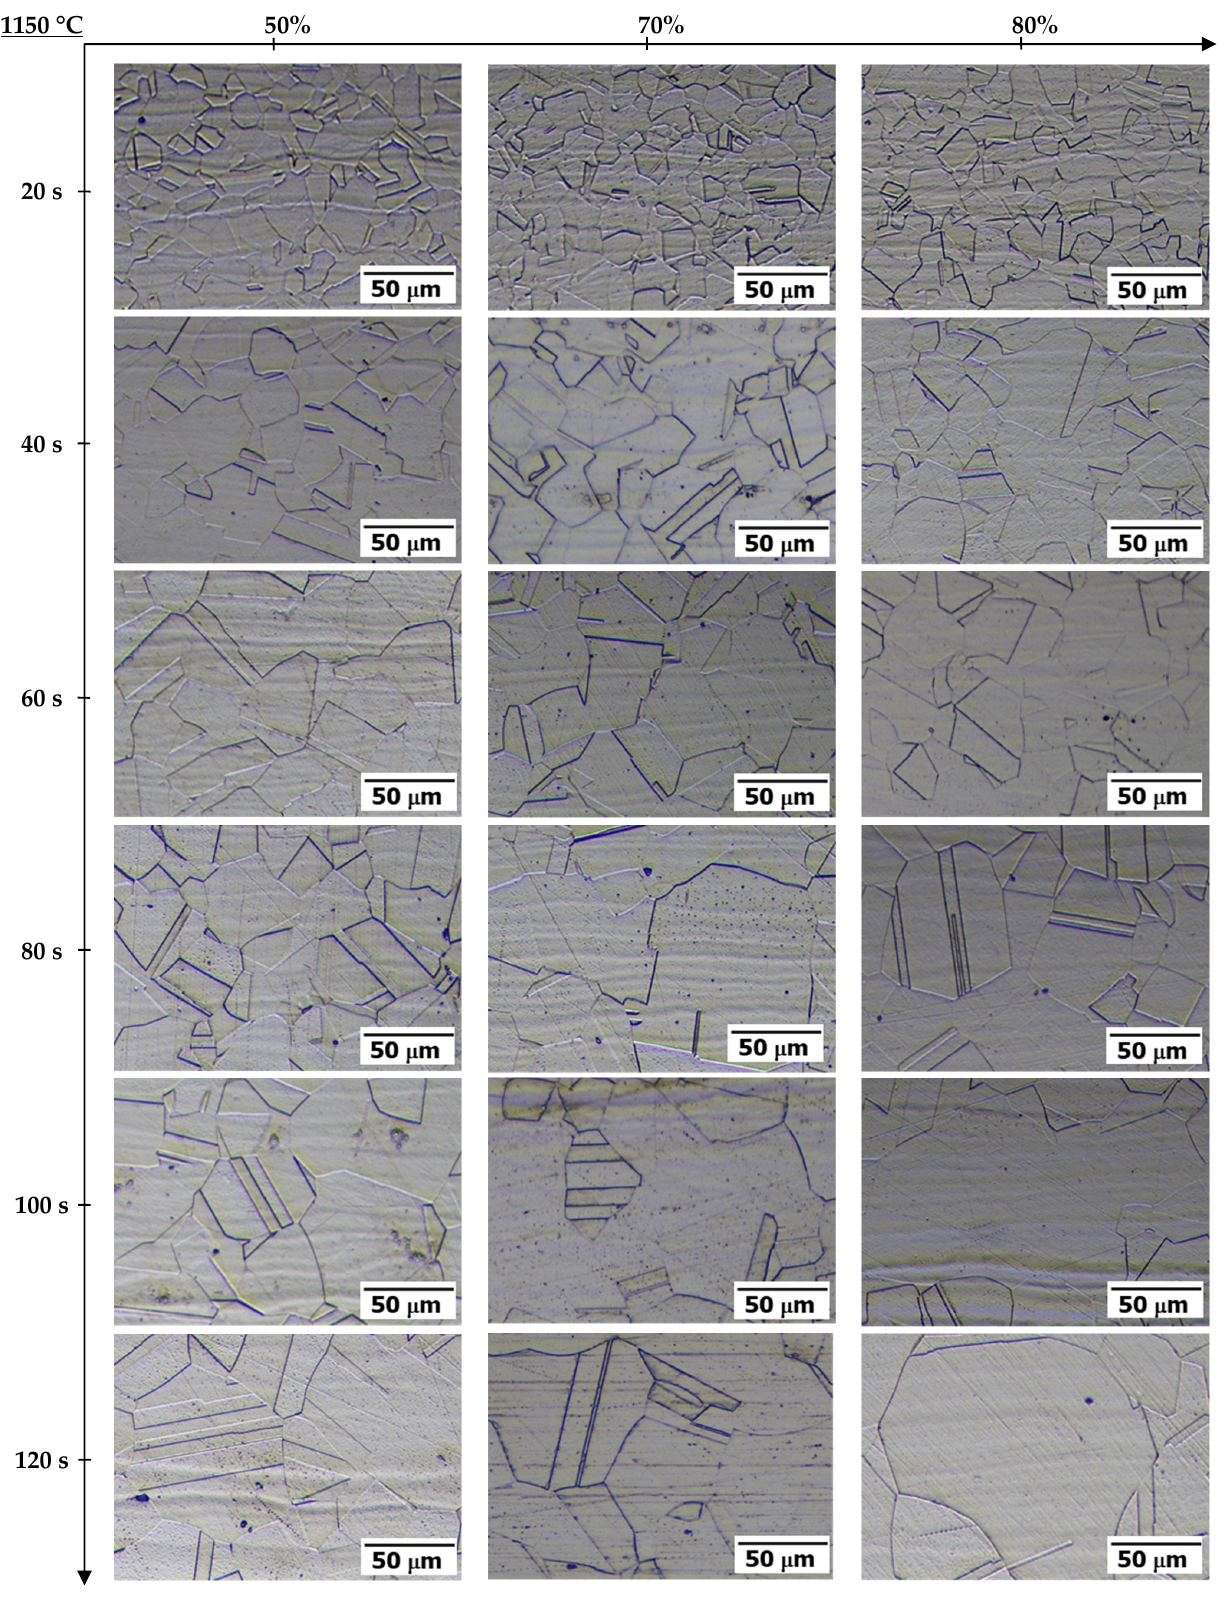
Figure 14. Grain growth evolution in AISI 904L as a function of the cold rolling ratio (CR: 50%, 70%, 80%) after annealing treatment at 1150 °C and soaking times in the range of 20–120 s.